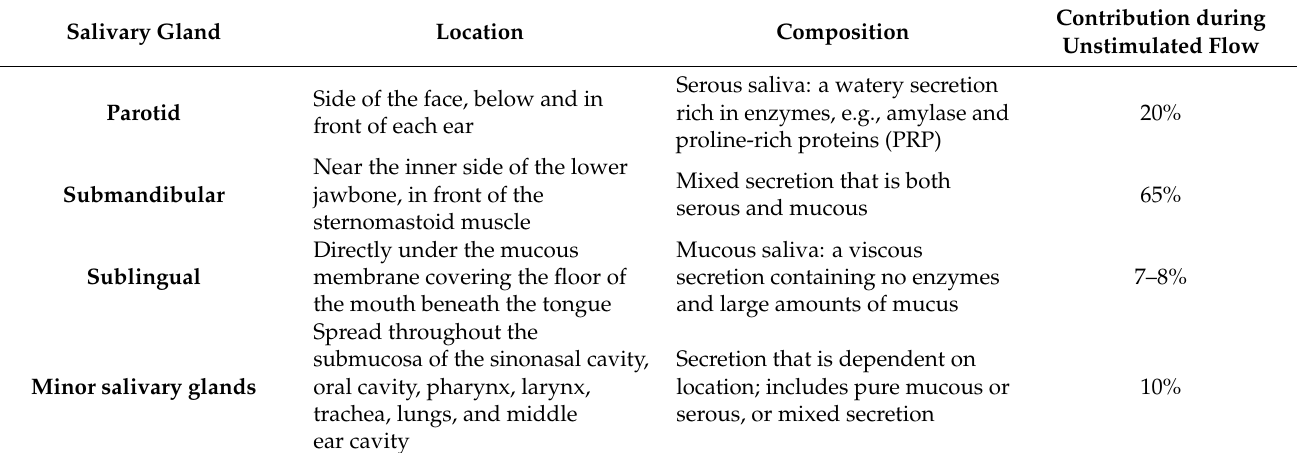
Figure 2. Locations of the major and minor salivary glands. Table 3. The different types of salivary glands, their location, composition and contribution to total saliva production.